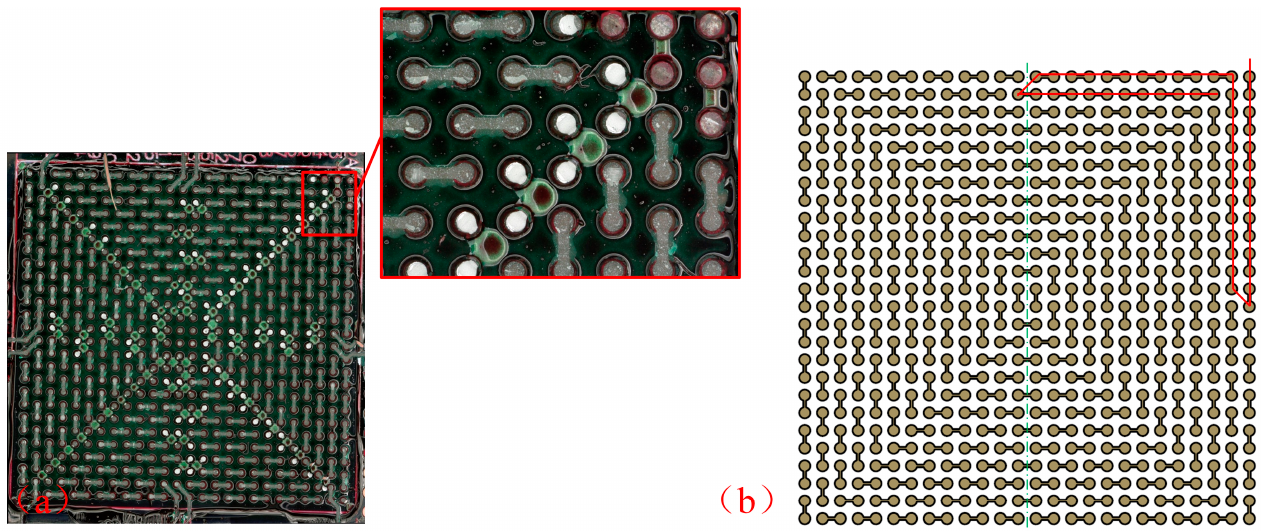
Figure 14. The random vibration tests results in D101: ( a ) dye and pry test results, ( b ) typical solder joint failure locations.